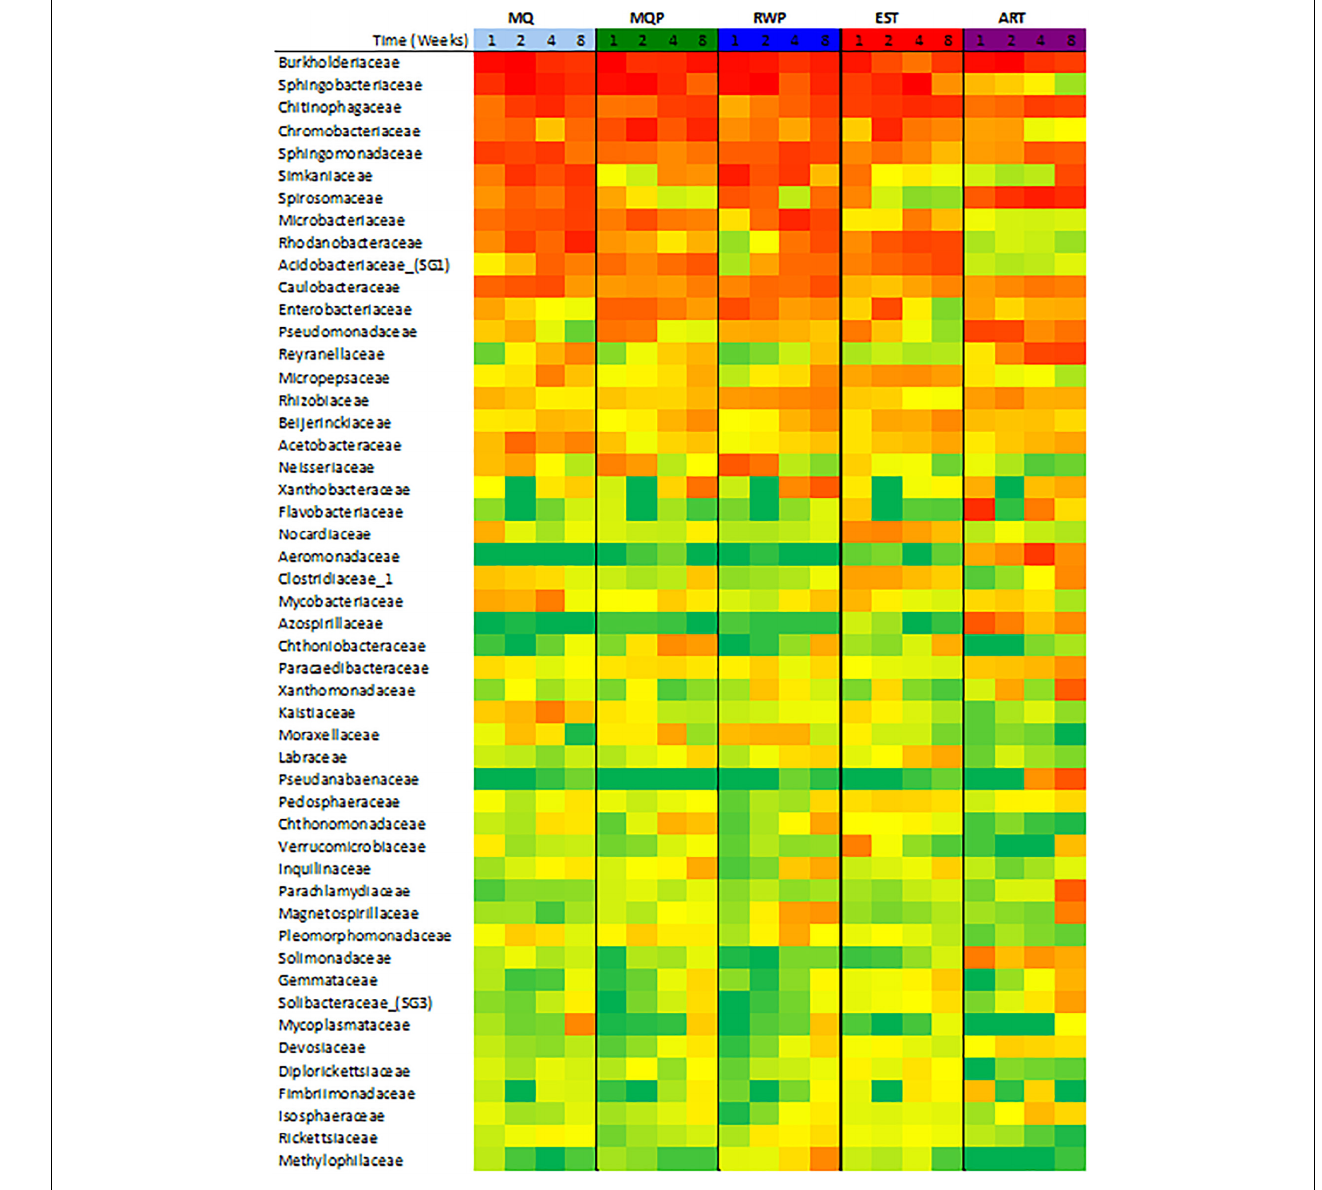
FIGURE 2 | Heatmap of the 50 most abundant bacterial families identified in samples across four timepoints in the five treatments (see Figure 1 ). Values are the logarithmic transformation of each family abundance with the color scale showing green as zero abundance and red as the highest abundance.